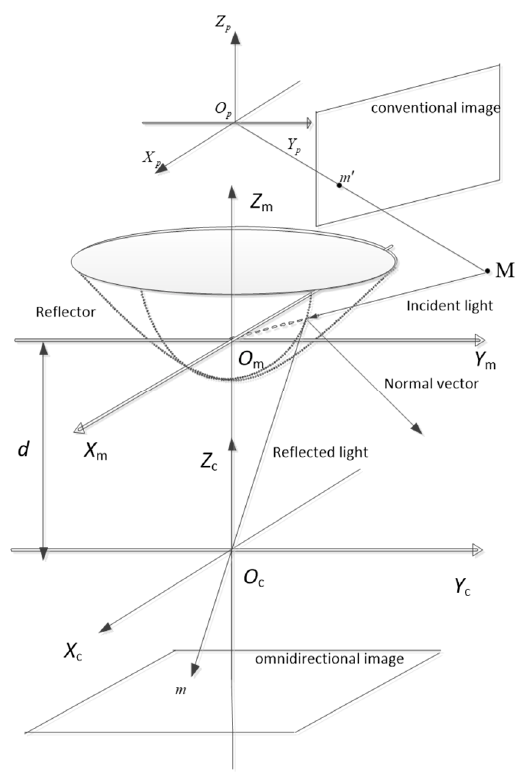
Figure 2. The configuration of the hybrid vision system. It consists of a perspective camera and a catadioptric camera with a hyperboloidal mirror.